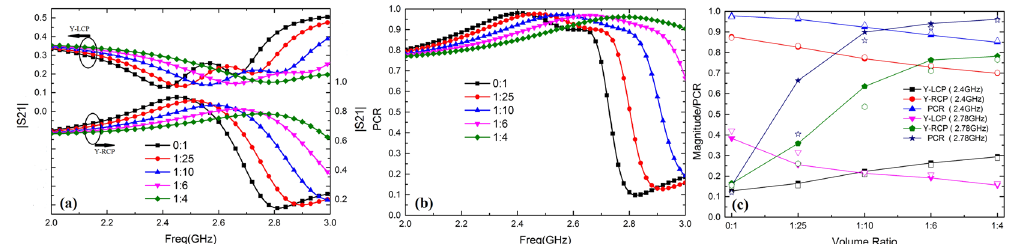
Table 3. The PCRs of Cross-Polarization at 2.45 GHz and 2.78 GHz for state 2 and state 3.